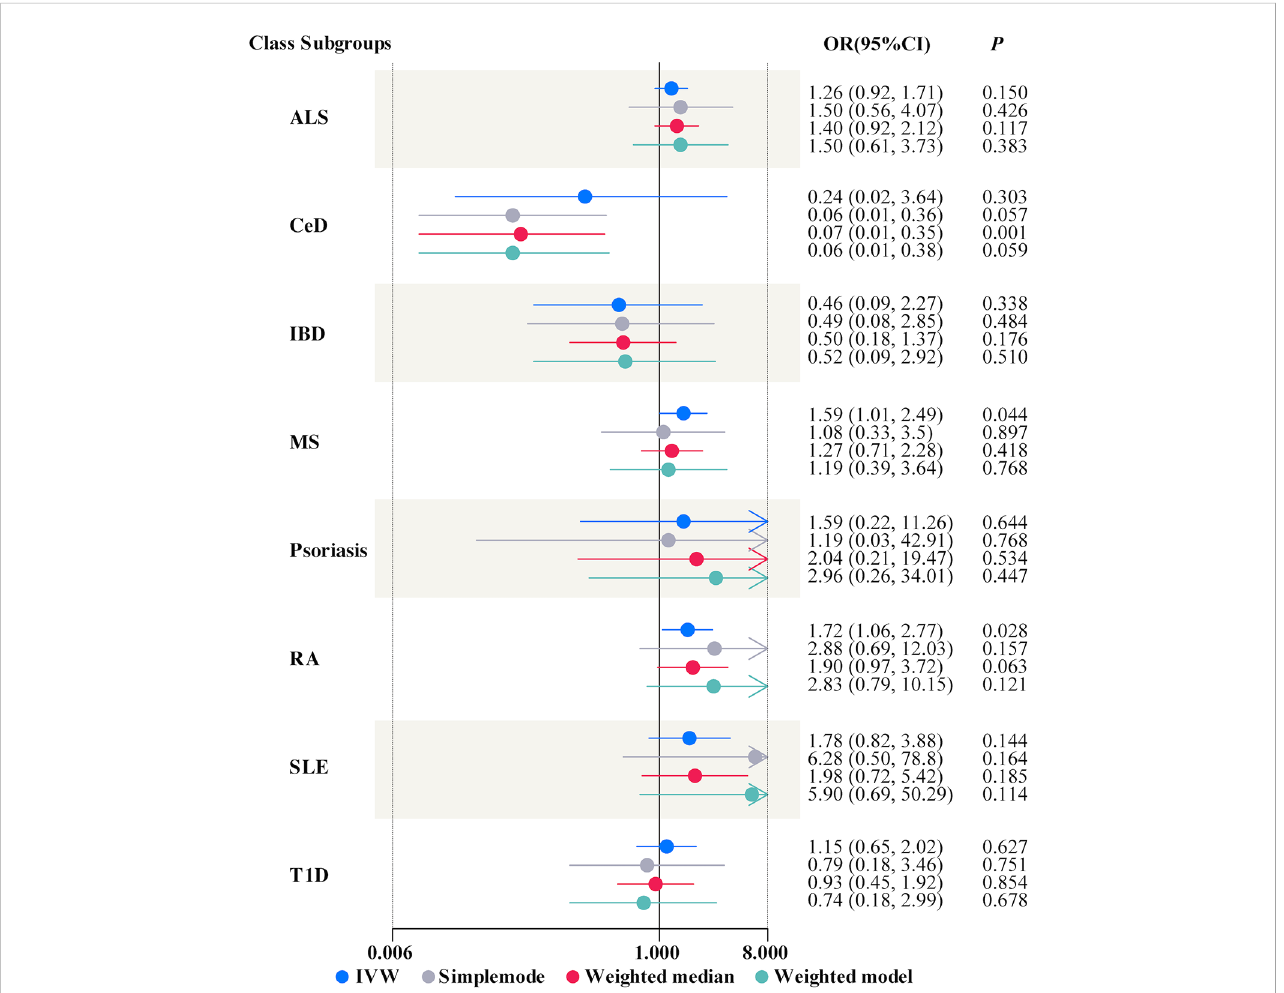
FIGURE 2 Forest plots summarizing the causal effects of multisite chronic pain on autoimmune diseases. OR, odds ratio; CI, con fi dence interval; ALS, amyotrophic lateral sclerosis; CeD, celiac disease; IBD, in fl ammatory bowel disease; MS, multiple sclerosis; RA, rheumatoid arthritis; SLE, systemic lupus erythematosus; T1D, Type 1 diabetes; IVW, inverse variance